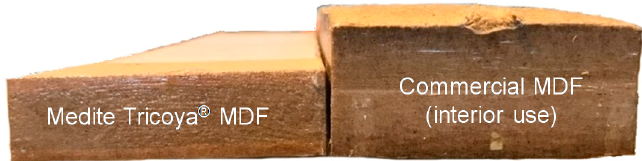
Figure 4. Medite Tricoya ® and commercial standard MDF (for interior use) samples after accelerated aging test. Note the double thickness in the commercial MDF sample.